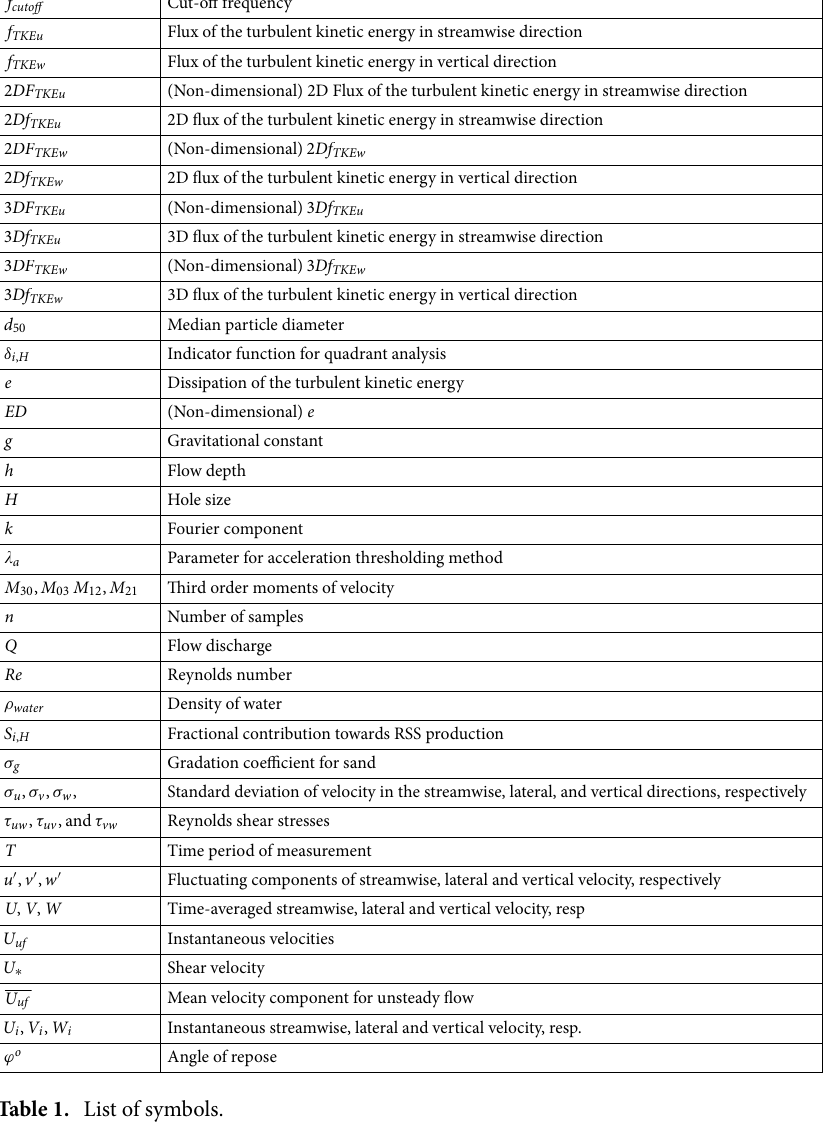
Table 1. List of